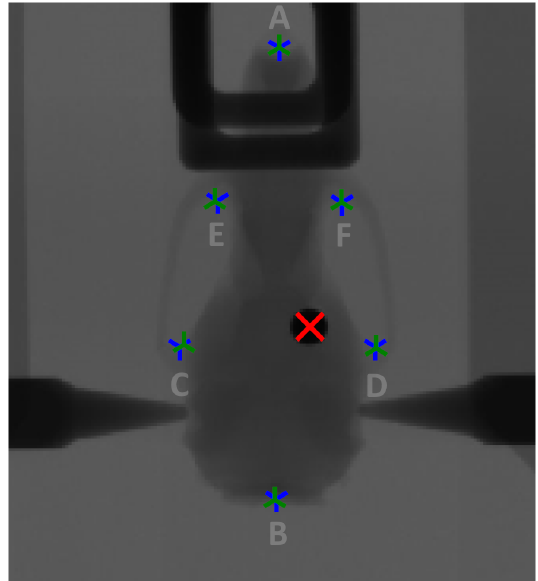
Figure 2. Planar X-ray image of the rat phantom on the DynMRT Stage superimposed with the manually identified skeletal landmarks from the X-ray image (tri-point blue), registered landmarks from the composite CT reconstruction (tri-point green) and inferred location of the centre of the ball bearing (red cross).